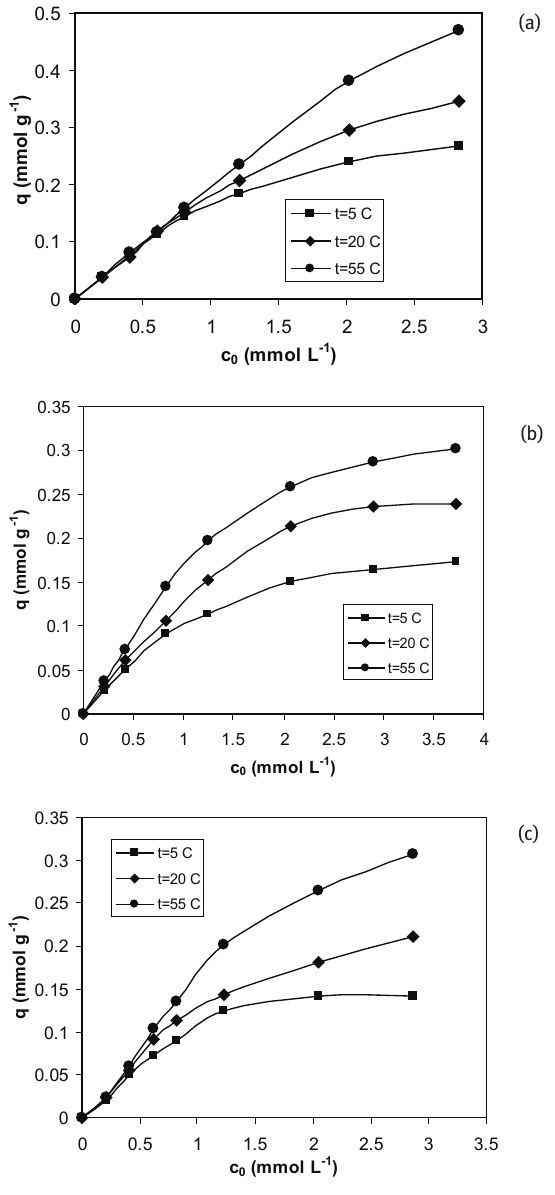
Figure 6: Effect of initial heavy metal concentration and temperature on the biosorption onto mustard waste biomass (pH = 5.5;